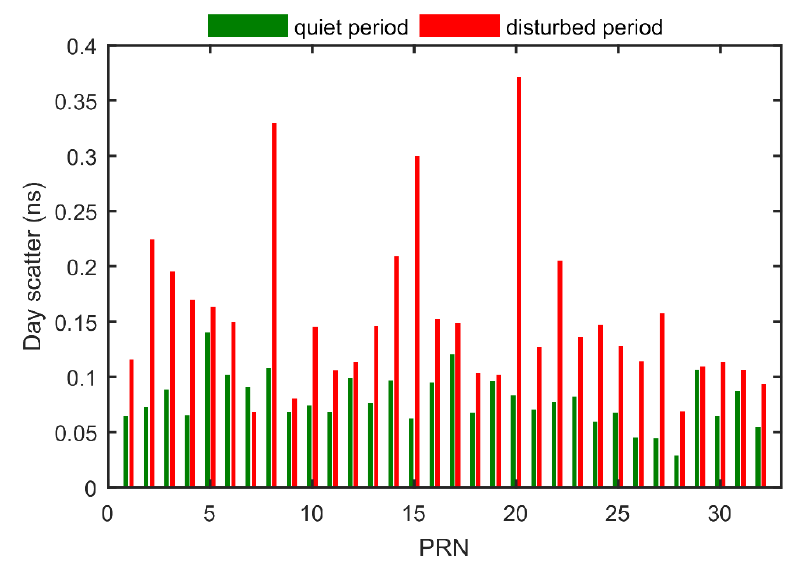
Figure 10. Day scatter of 32 GPS satellite DCBs during quiet period and disturbed period.